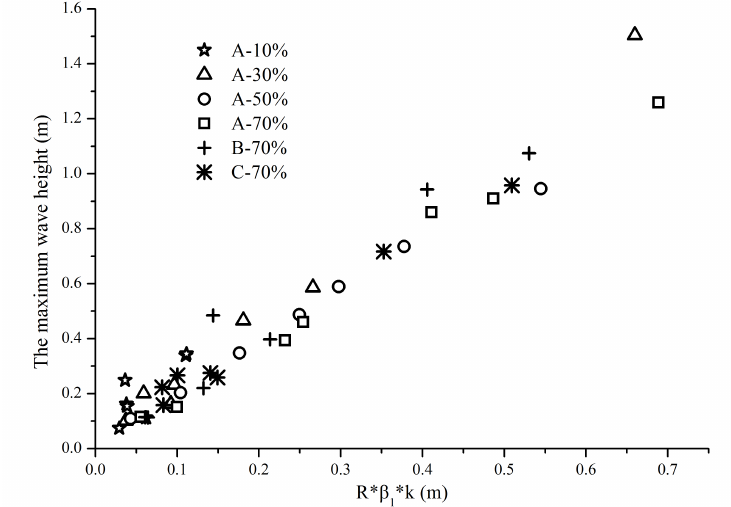
Fig. 6 Two-dimensional distribution of h and R β 1 k